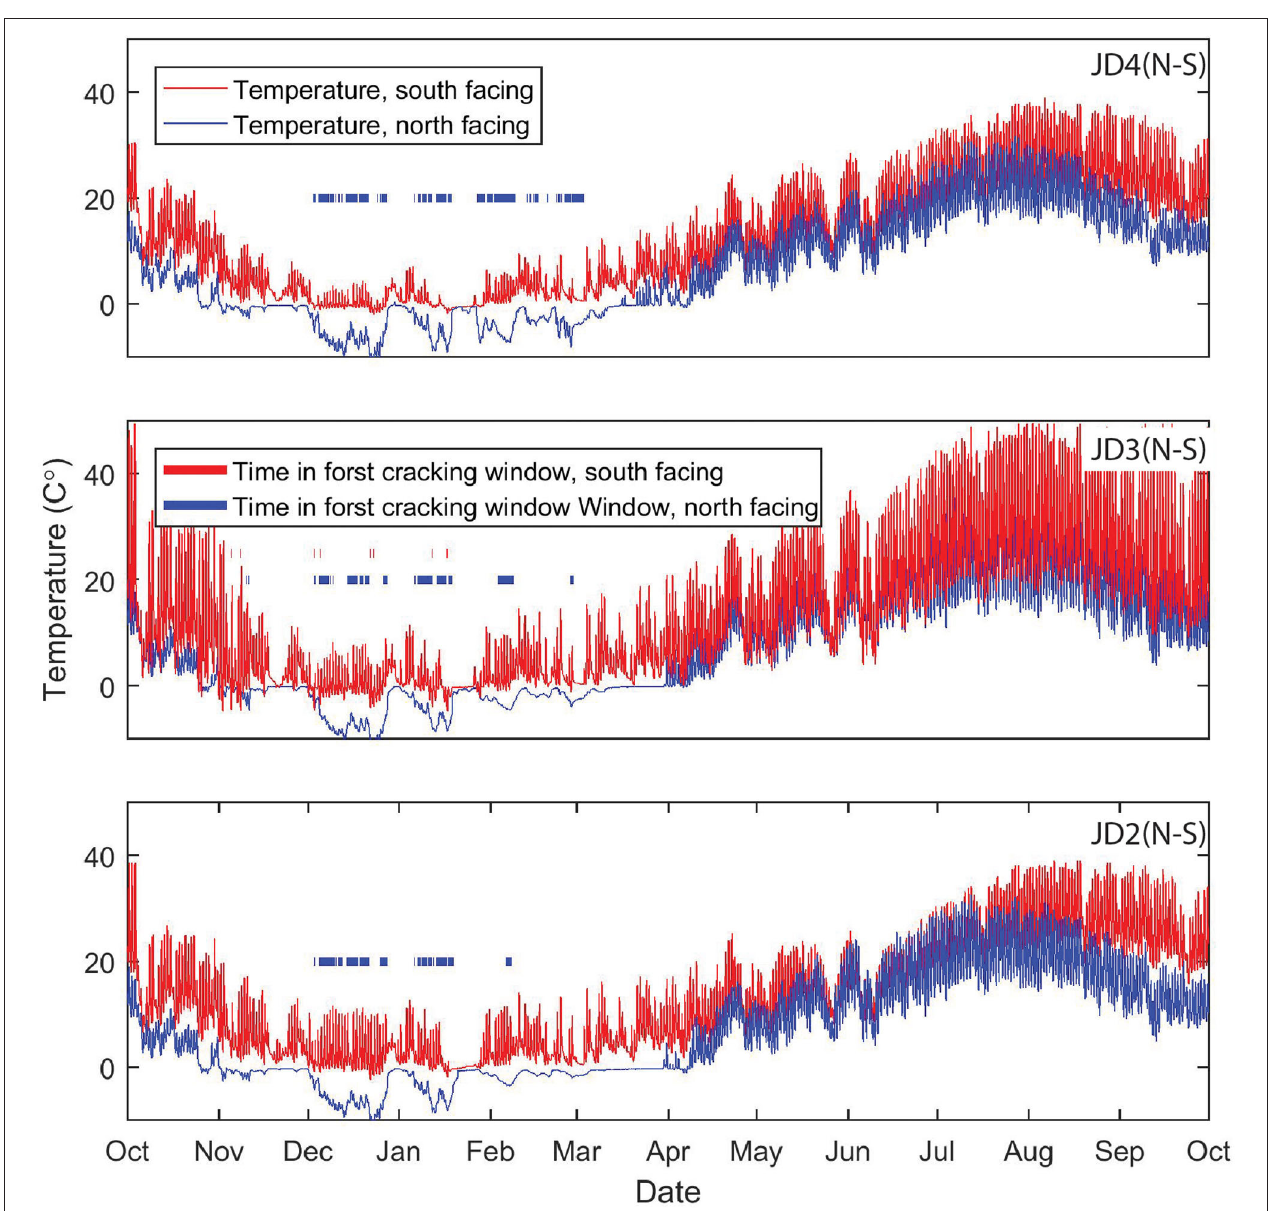
FIGURE 11 | Soil temperature measured at 5cm depth with TDR probes at the JD2(N–S), JD3(N–S), and JD4(N–S) instrument sites for the 2012 water year. The blue and red lines indicate the instruments on the north and south facing slopes, the thick red and blue lines indicate times then the sensors were between − 3 and − 8 ◦